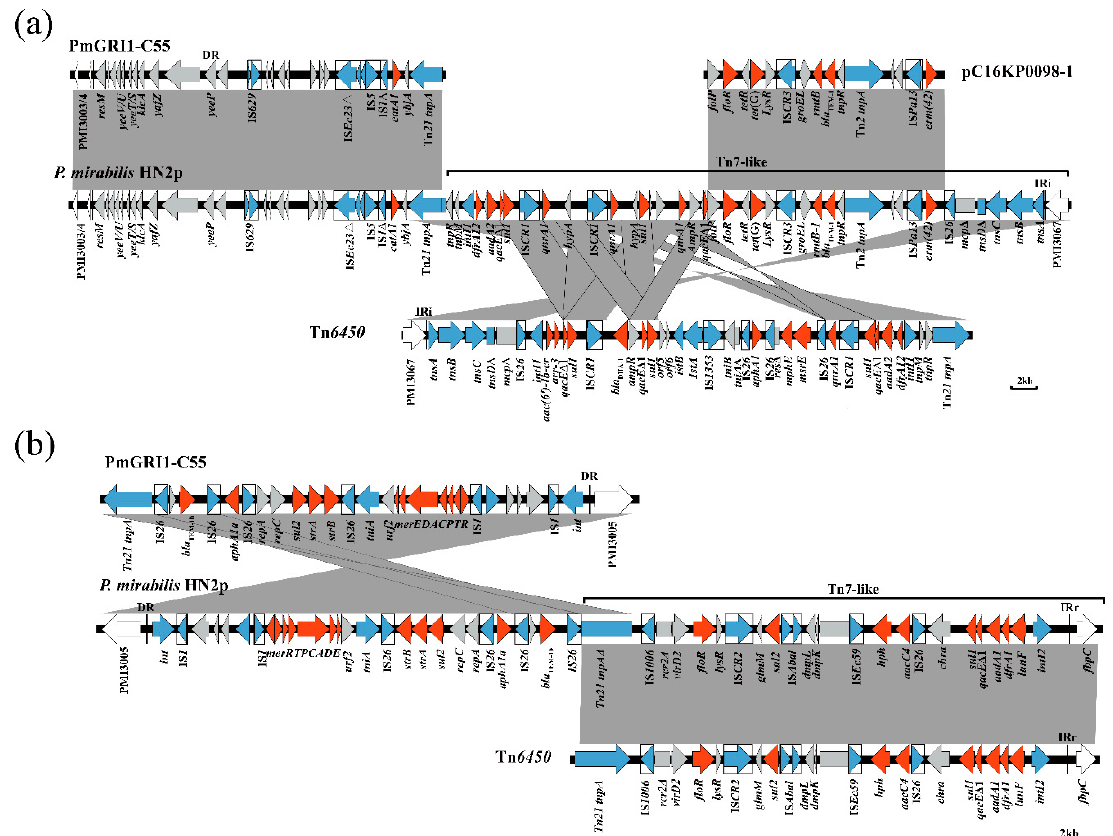
Figure 2. Genetic structures of the hybrid structure: ( a ) front end and ( b ) back end. Structures are drawn to scale from NCBI accession numbers MT585156 (hybrid structure in P. mirabilis HN2p), MK861851 (PmGRI1-C55), MF805806 (Tn6450), and CP052444 (pC16KP0098-1). Genes and ORFs are shown as arrows, and arrowheads indicate their transcription orientations. Shared regions with an identity of over 99% are indicated by shading. Antimicrobial resistance genes are in red, and transposase or integrase genes are in blue. The gray arrows represent other functional genes that have nothing to do with this research. The IS elements are indicated by boxes around the blue arrows. DR represents the 20-bp direct repeats at the ends of PmGRI1-C55. IRi and IRr are the inverted repeats that define the left and right ends of Tn6450,